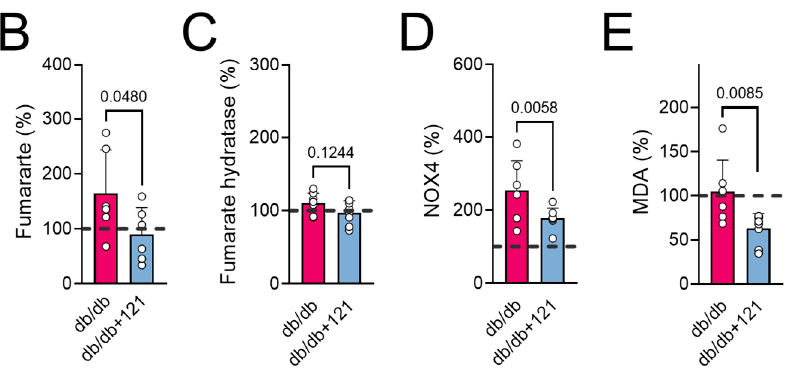
Figure 7. NOX4, MDA, and fumarate are modulated by the CMS121 diet. ( A ) Representative blot images of kidney extracts and their quantification: ( C ) fumarate hydratase (FH), ( D ) NOX4, and ( E ) MDA. ( B ) Fumarate levels in urine obtained from the metabolomic study (Figure 6). Vertical lines indicate non-adjacent lanes from the same blot, and dashed lines adjacent groups. Data are presented as mean ± SD (n = 6–8). p -values are indicated for the untreated db/db mice compared to the CMS121-treated mice. Values were normalized to WT group (dashed line), and data are presented as percentages of WT values. One-way ANOVA was used to detect mean changes, and differences between db/db and db/db + 121 were evaluated by the Holm–Sidak post-hoc test.